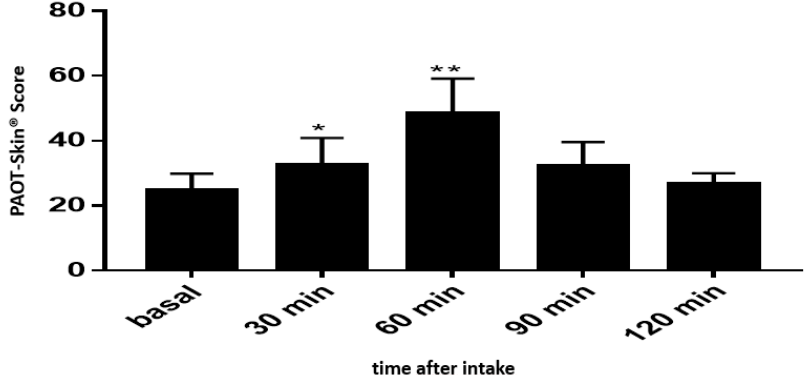
Figure 6. Intake of 400 mL orange juice containing 244 mg vitamin C and incidence on the PAOT-Skin Score ® according to time (Group V). * p = 0.047; ** p = 0.011.